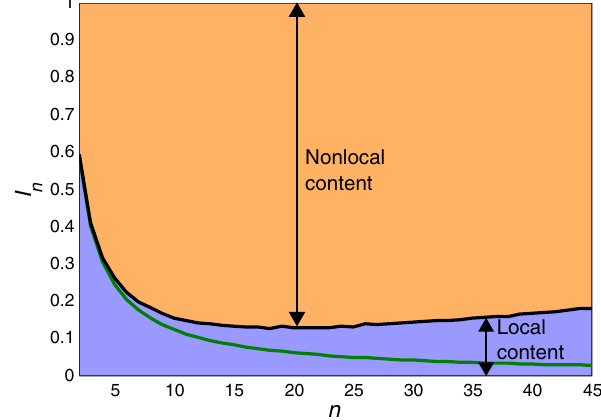
FIG. 5. A plot of the measured chained Bell inequality values for n ¼ 2 to n ¼ 45 . Here, the local limit is I n ¼ 1 and the no- signaling limit is I n ¼ 0 . The quantum boundary in this case is the green line; our measured Bell inequality values are connected by the black line, with the error bars lying within the thickness of the line. The local content for a given n is represented by distance from 0 to the measured I n value (black line), which is colored blue, and the nonlocal content is the distance from the measured value to 1, colored orange. As the value of I n approaches 0, the correlations present in the system match those of a PR box — if I 0 were measured, the system would require the use of a PR n ¼ box for every measurement. Our measured points deviate from the quantum boundary due to the 0.3% noise from imperfect state preparation, which becomes more noticeable with larger number of measurements (e.g., I 45 requires 360 specific measurements along the Bloch